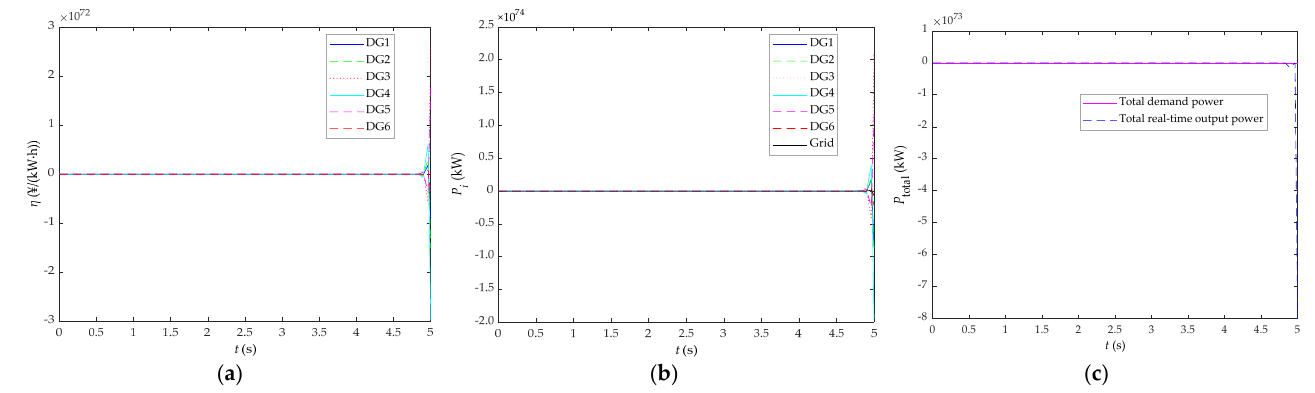
Figure 15. The change curves of variables of the system when ζ is set as 10: ( a ) change curves of each DG’s ICR; ( b ) change curves of each DG’s active output and grid output power; ( c ) change curves of the cumulative sum of each DG’s active output and grid output power as well as total demand power.